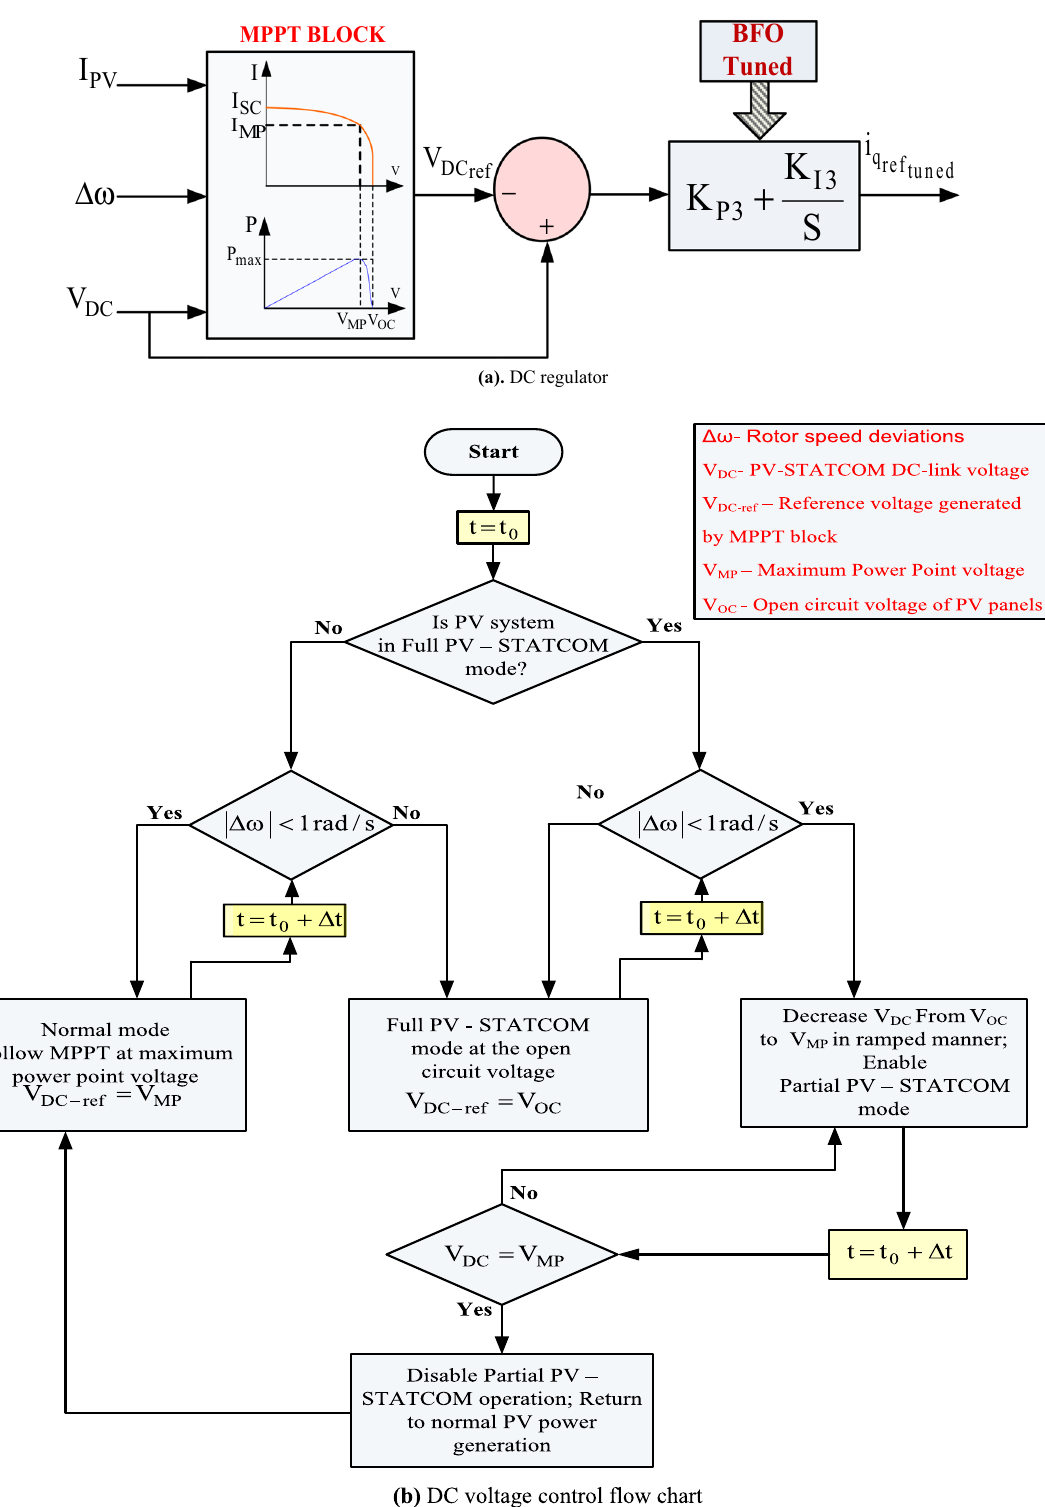
Fig. 4 a DC regulator, b DC voltage control flow